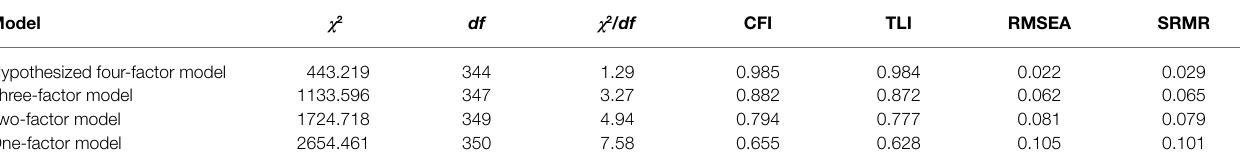
TABLE 2 | Comparison of measurement models.